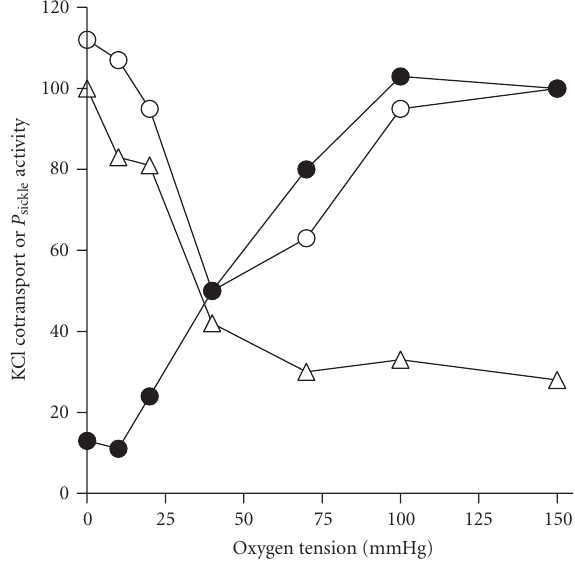
Figure 2: E ff ect of oxygen tension on the activity of KCl cotransport (KCC) or P sickle in red blood cells (RBCs) from normal indi- viduals or patients with sickle cell disease. The activity of each transport pathway is normalised—to the value in oxygenated cells (150mmHg O 2 ) for KCC activity and for that in deoxygenated RBCs (0mmHg) in the case of P sickle —and given as a percentage. Solid circles give KCC activity in RBCs from normal HbAA individuals; open symbols give KCC activity (open circles) or P sickle activity (open triangles) in RBCs from sickle cell patients (HbSS homozygotes). In these experiments, total magnitude of KCC activity was about 10-fold greater in RBCs from HbSS individuals compared with HbAA ones. Note how the deoxygenation-induced KCC activity and activation of P sickle follow a similar dependence on O 2 tension. Data taken from